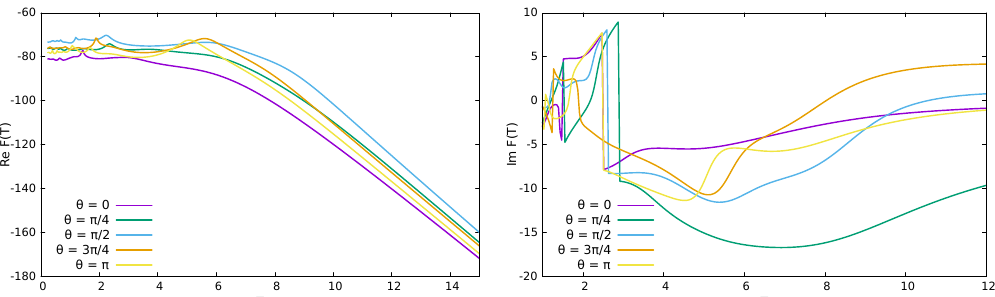
Figure 13: Free energy for N = 34, r = 2 and different θ ’s. The random couplings are the same for all angles. Qualitatively, results do not depend much on θ , especially those corresponding to the real part of the free